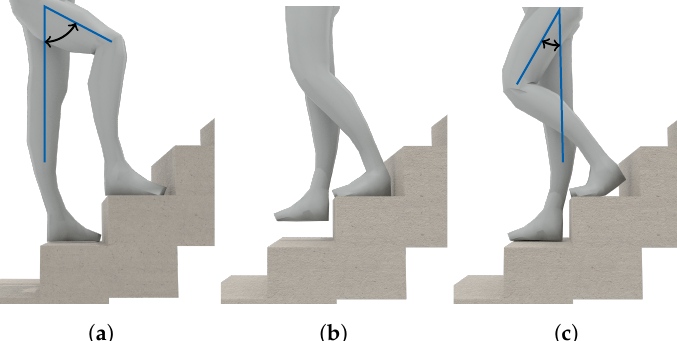
Figure 3. Typical poses and movements exhibited while walking stairs. ( a ) demonstrates the high inclination typically exhibited during the ascend of stairs. ( b , c ) demonstrate the typically much smaller thigh inclinations during the descend of